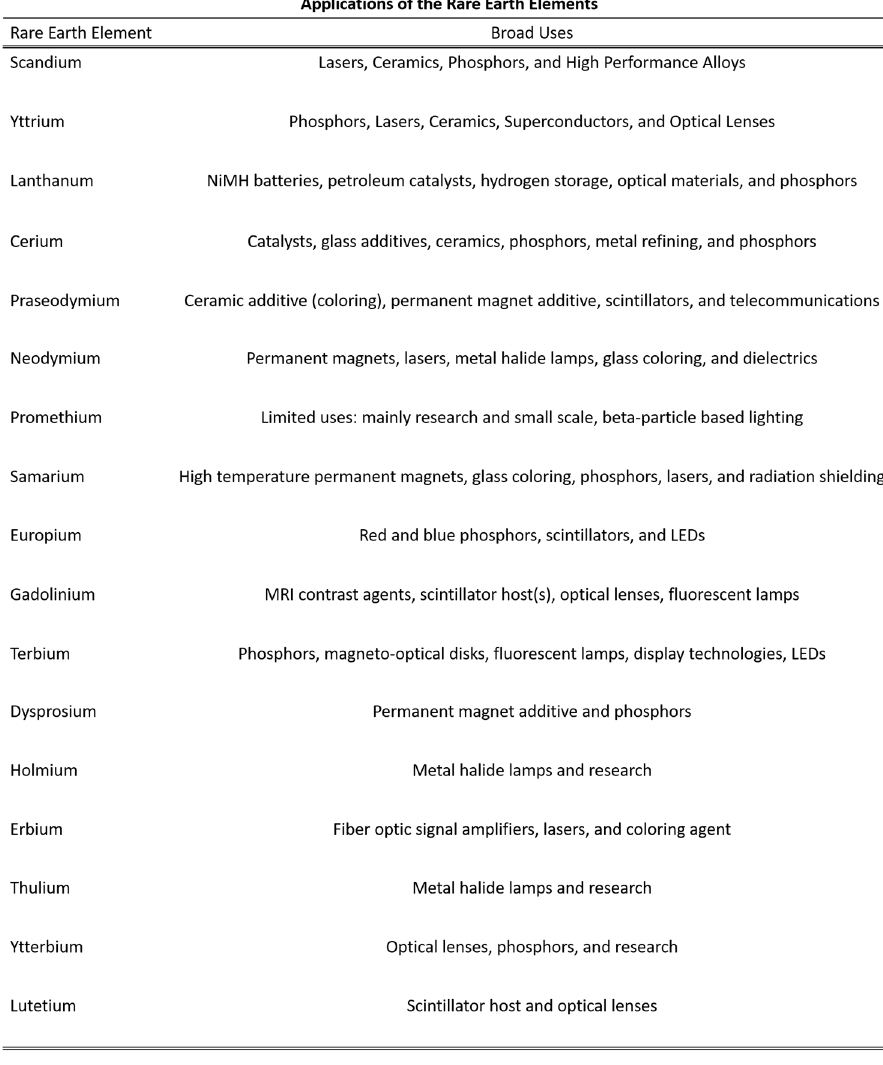
Figure 1. Applications of the rare earth elements broken down by element. Most applications are geared towards high-technology, such as lasers, magnets, phosphors, energy conversion, and catalysis. Adapted from Gschneidner, Jr. [2].